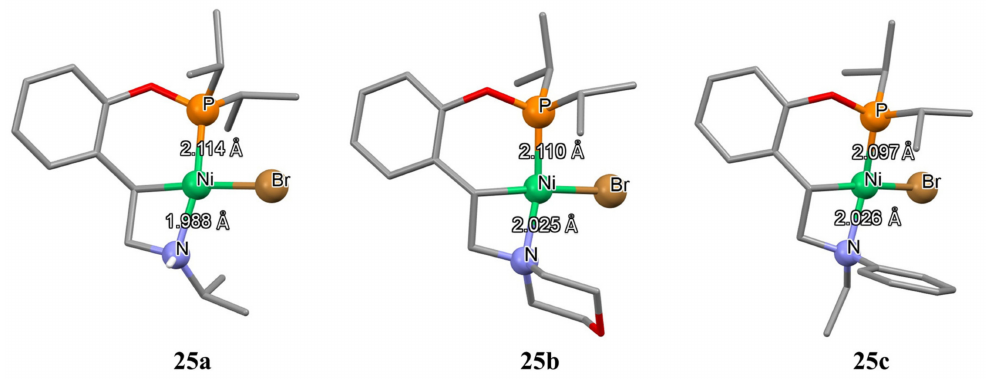
Figure 6. Crystal structures of the unsymmetrical PC sp3 N nickel pincer complexes 25a , 25b , 25c [109].